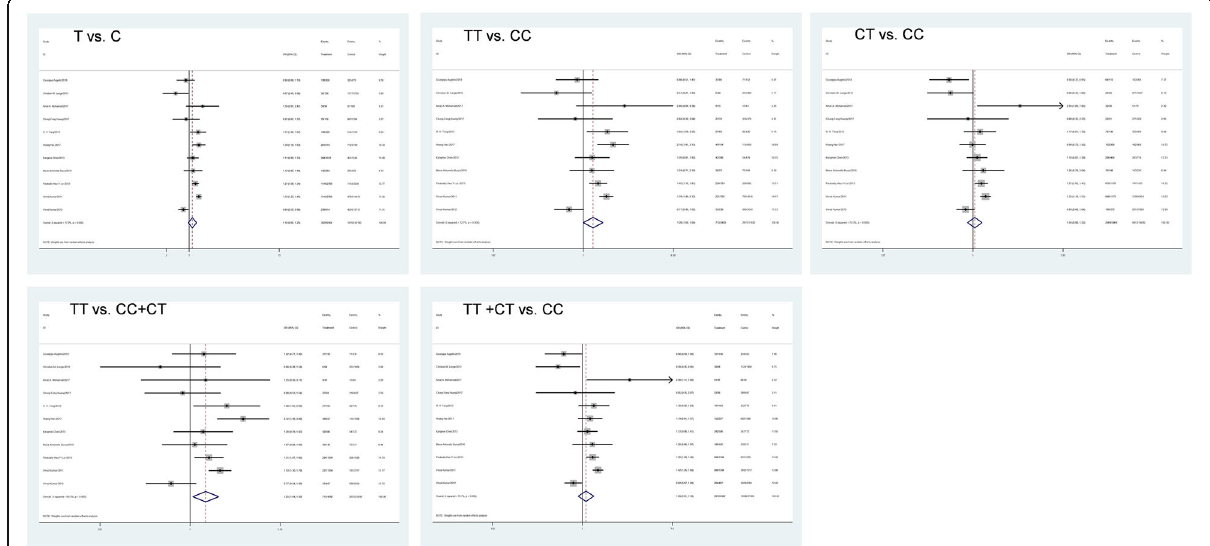
Fig. 2 Forest plots of rs2596542 and HCC in different genetic